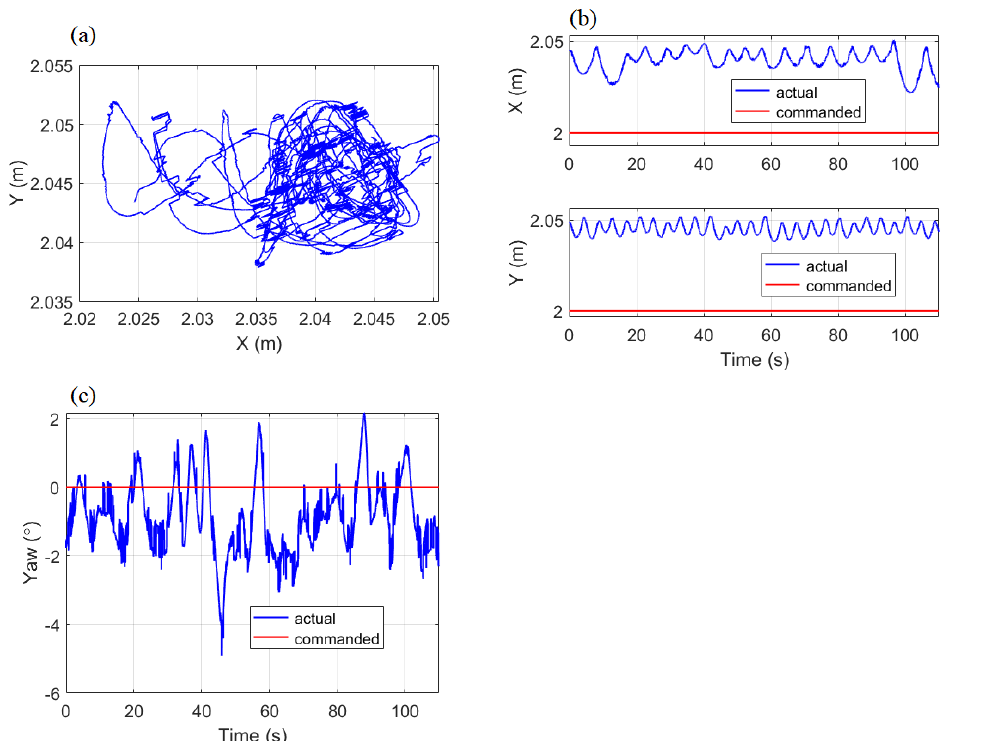
Figure 13. Results of regulation control using SMC. ( a ) Position trajectory in XY plane. ( b ) Time history of actual and commanded positions. ( c ) Time history of actual and commanded yaw angles.